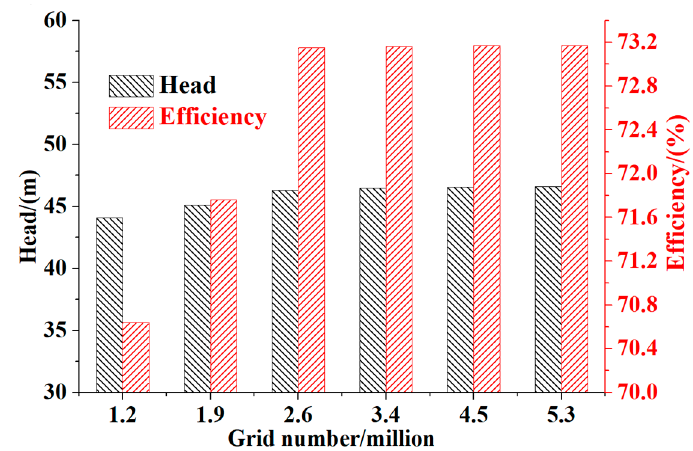
Figure 7. Grid distribution in the volute.